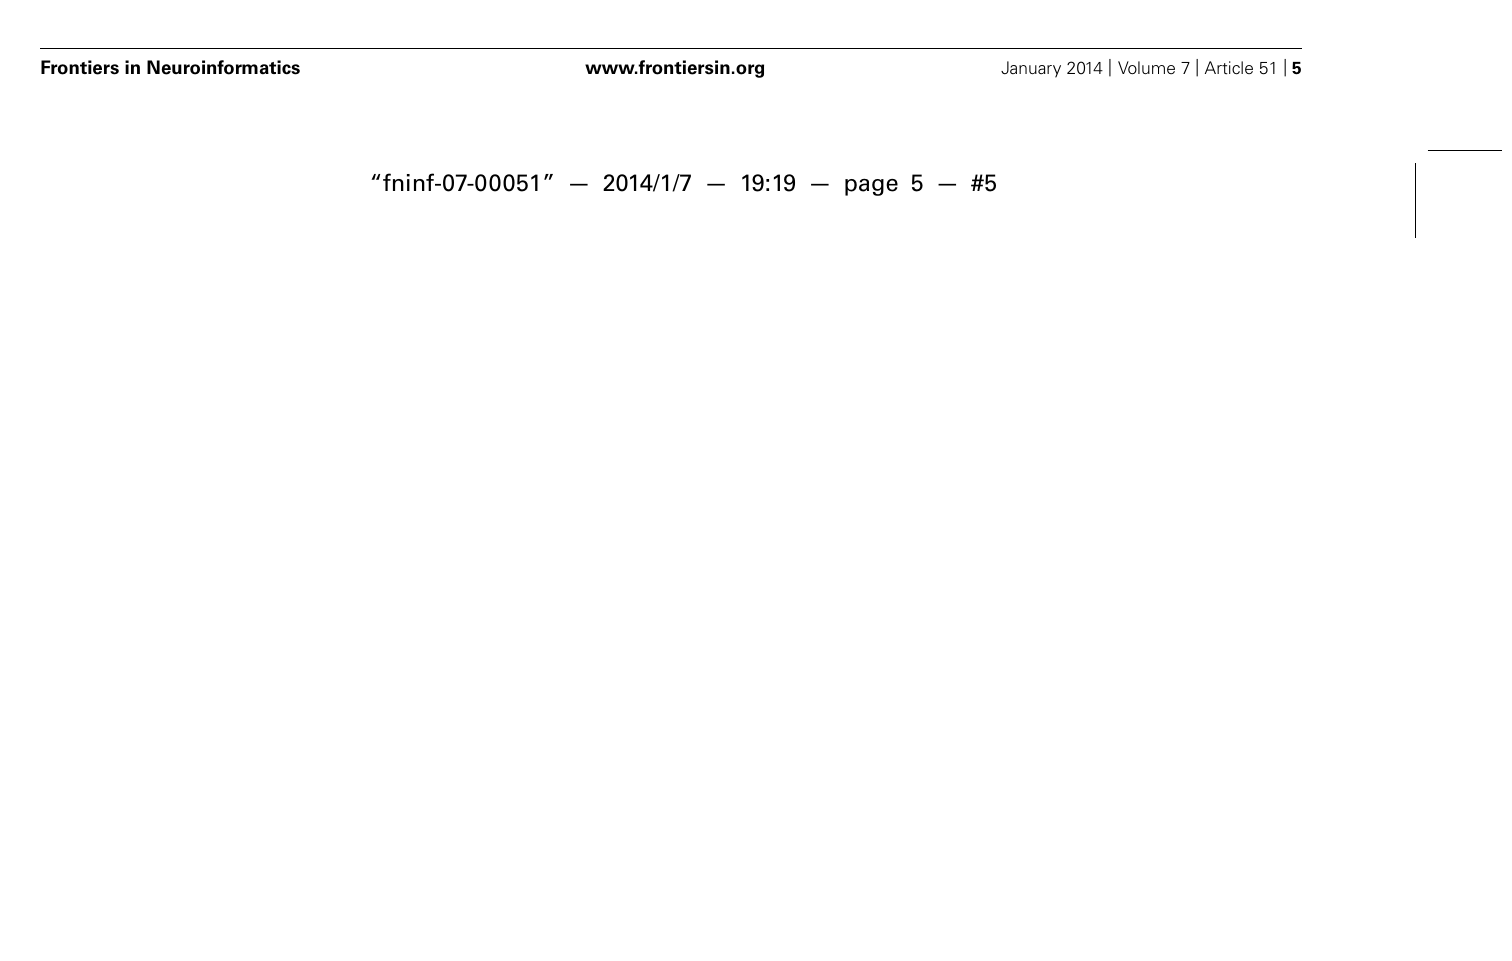
FIGURE 4 | DTIAtlasBuilder steps, GUI, and registration progression. (A) DTIAtlasBuilder steps. Black solid arrows indicate transform computation. Blue solid arrows indicate transform application. Hollow black arrows indicate an averaging of transformed images. Before the Affine registration in step 1, fractional anisotropy (FA) is normalized so that FA intensity difference between subject images does not bias the atlas creation. The FA is also “filtered” to remove negative eigen values, which will adjust the resulting FA values to scale between zero and one. The transform computed in step 4 final resampling, diffeomorphic transform (B) , is termed